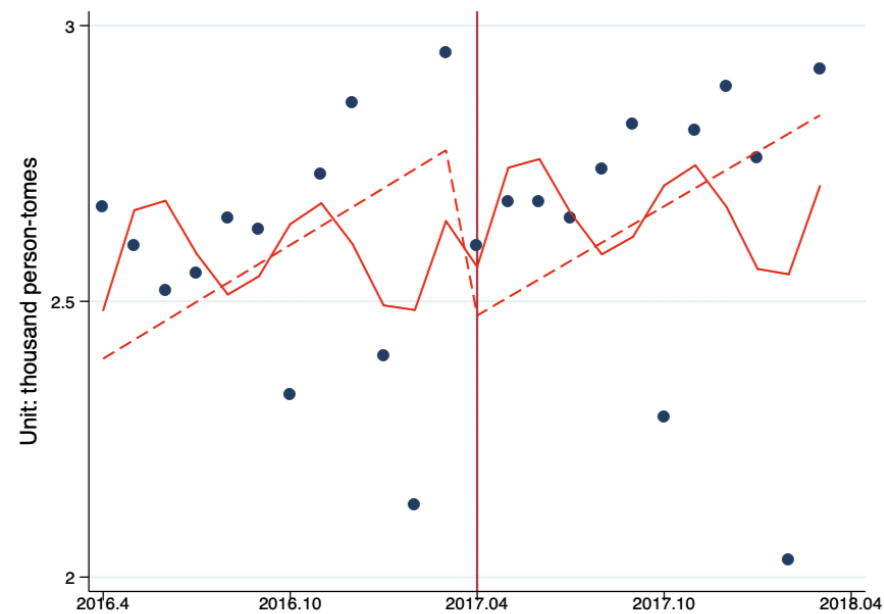
Figure 4. The ITS analysis of monthly inpatient visits in per tertiary hospital. Model adjusted for seasonality and autocorrelation. Solid line: predicted trend based on the seasonally adjusted regression model. Dashed line: de-seasonalized trend. Vertical line: intervention began. Blue dots: actual number.